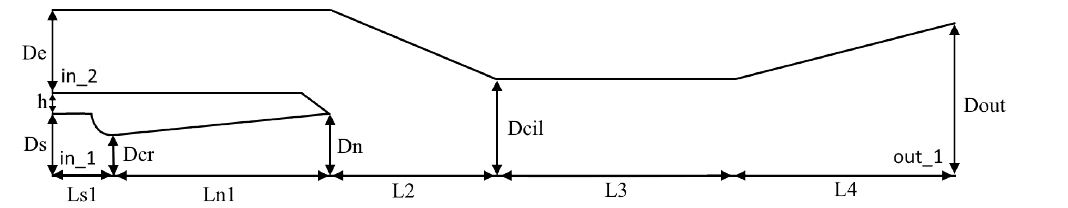
Figure 10. The geometry of the ejection filtration device. Table 2. Ejector device geometry.